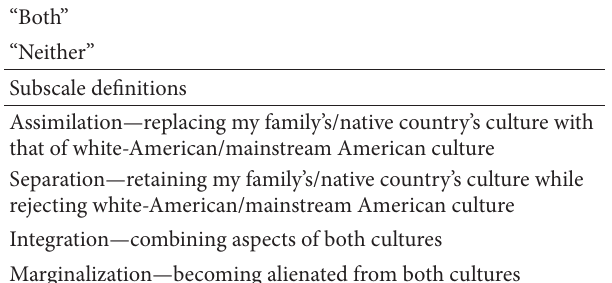
Table 1: Acculturation, Habits, and Interests Multicultural Scale for Adolescents (AHIMSA) questionnaire and response items. Questionnaire items “I am most comfortable being with people from ... ” “My best friends are from ... ” “The people I fit in with best are from ... ” “My favorite music is from ... ” “My favorite TV shows are from ... ” “The holidays I celebrate are from ... ” “The food I eat at home is from ... ” “The way I do things and the way I think about things are from ...